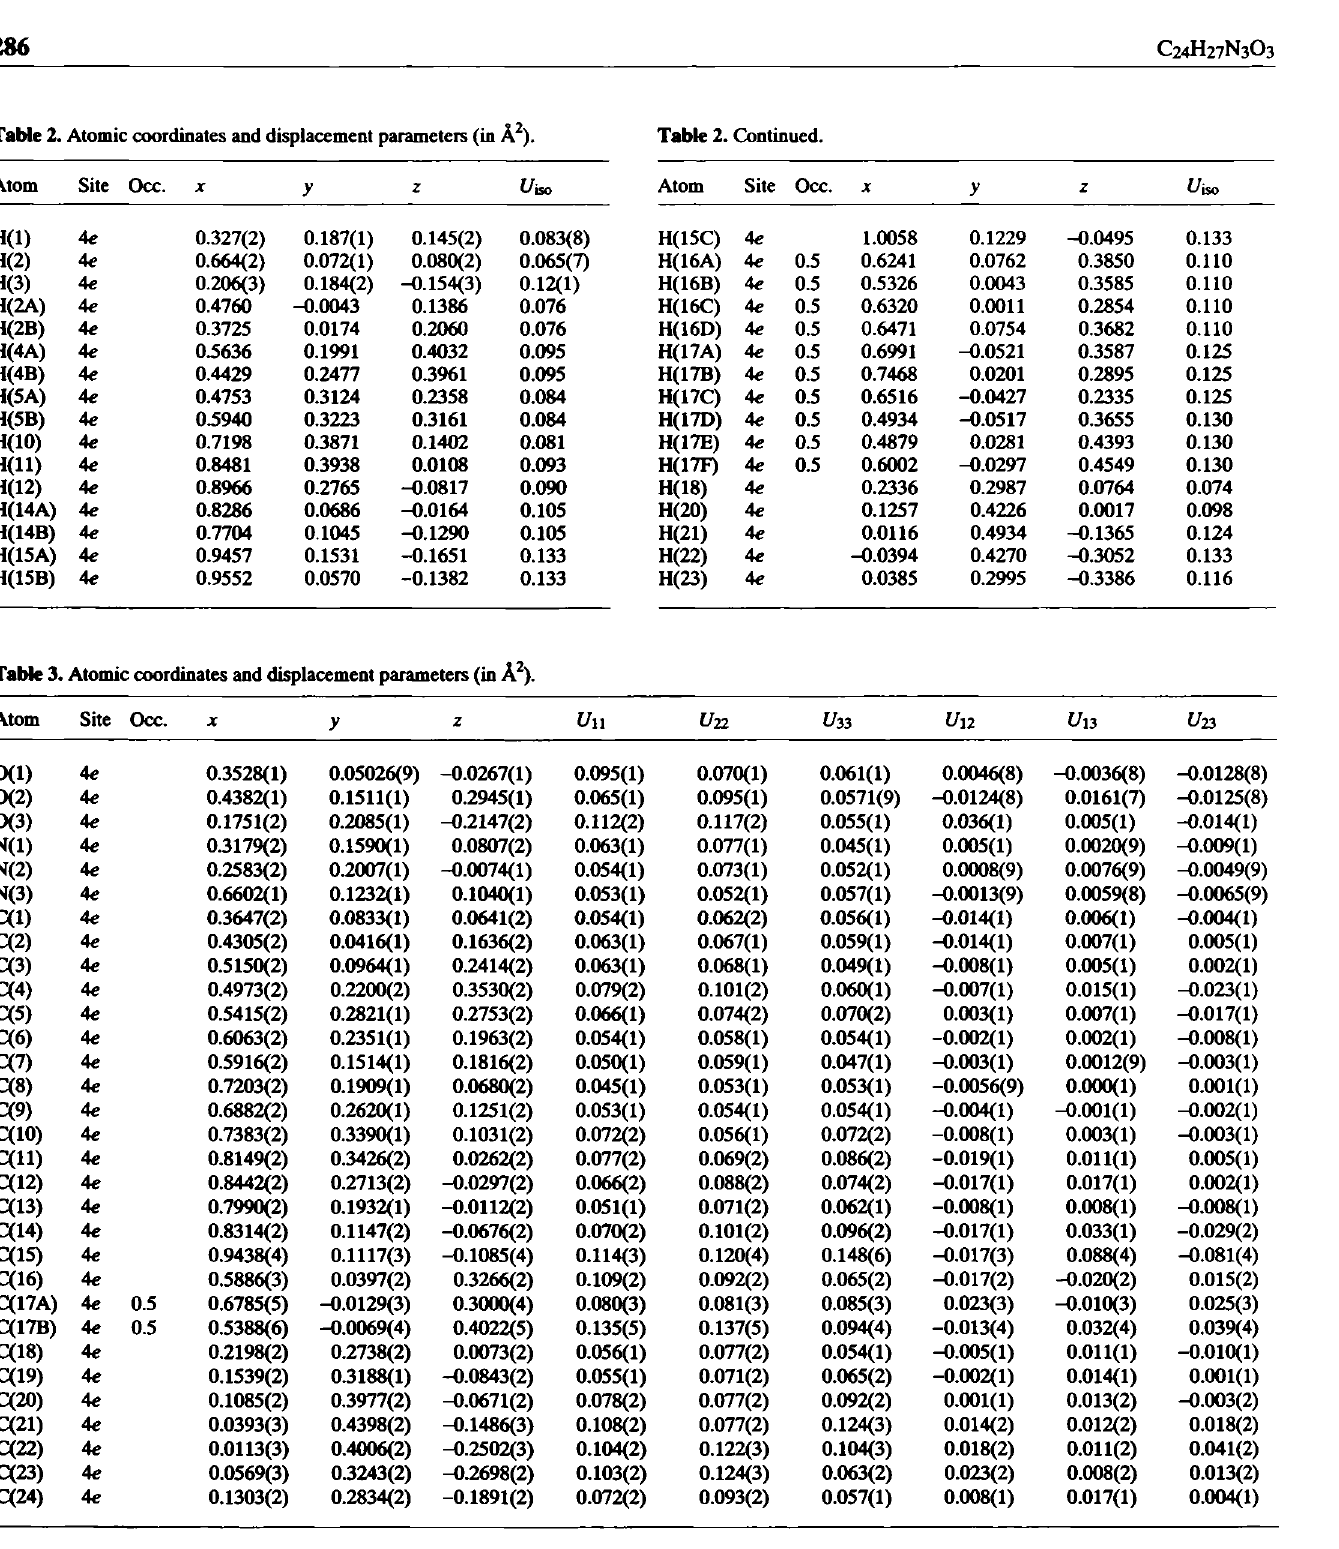
Table 2. Atomic coordinates and displacement parameters (in A 2 ).